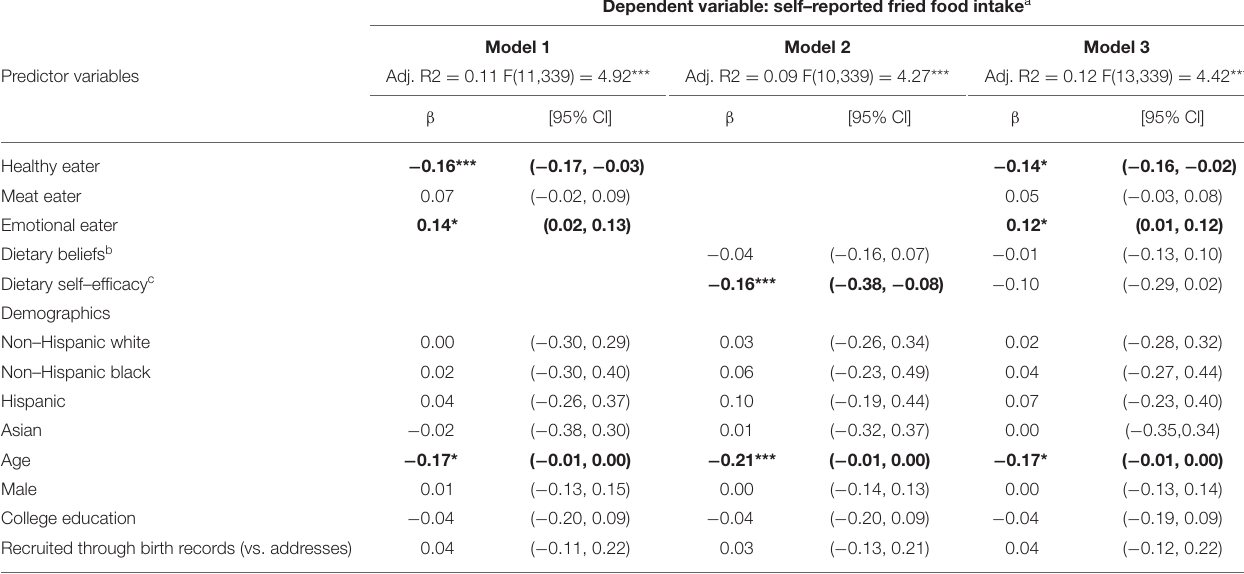
TABLE 7 | Linear regressions predicting self–reported fried–food